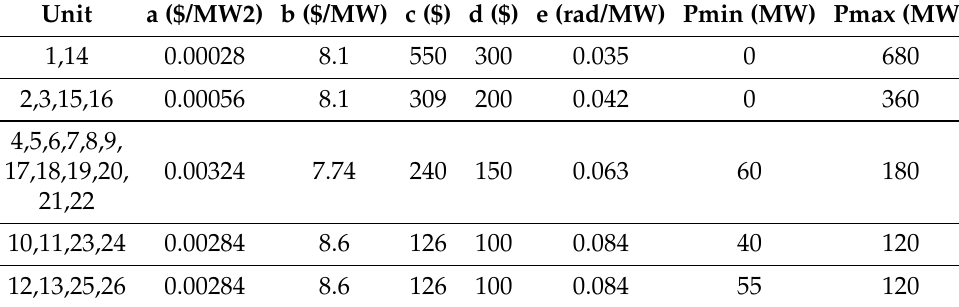
Table A13. Electrical Energy Generator unit data for Case Study